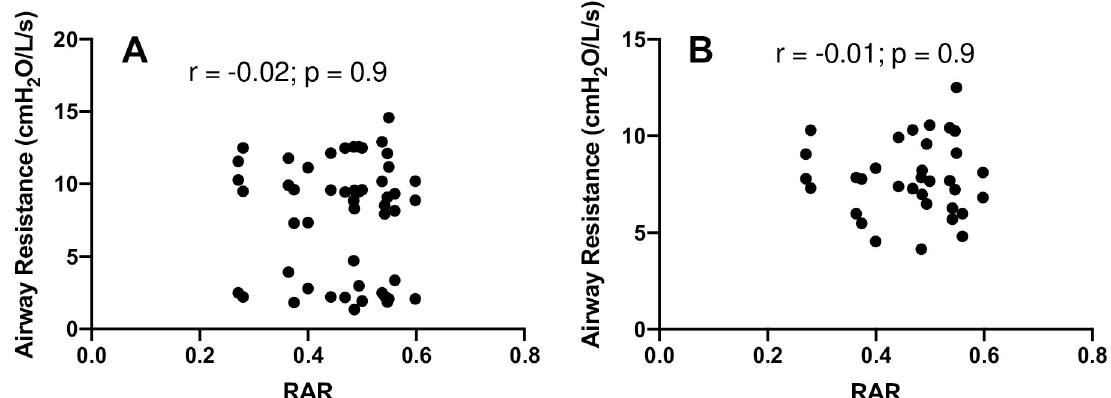
Fig 7. Rectangular Area Ratio (RAR) vs airway resistance variables with and without imposed expiratory resistance. Panels A and B show no correlation between the